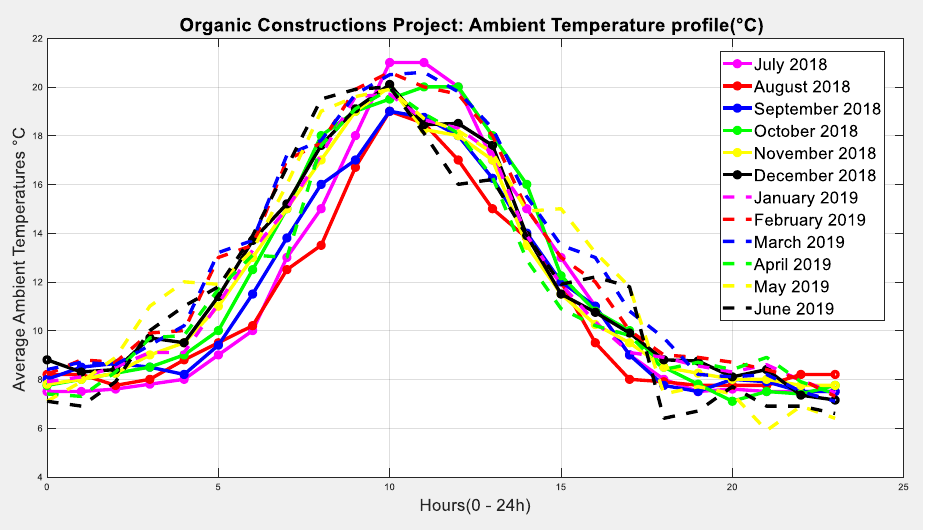
Figure 11. Ambient temperature profile (July 2018–June 2019).